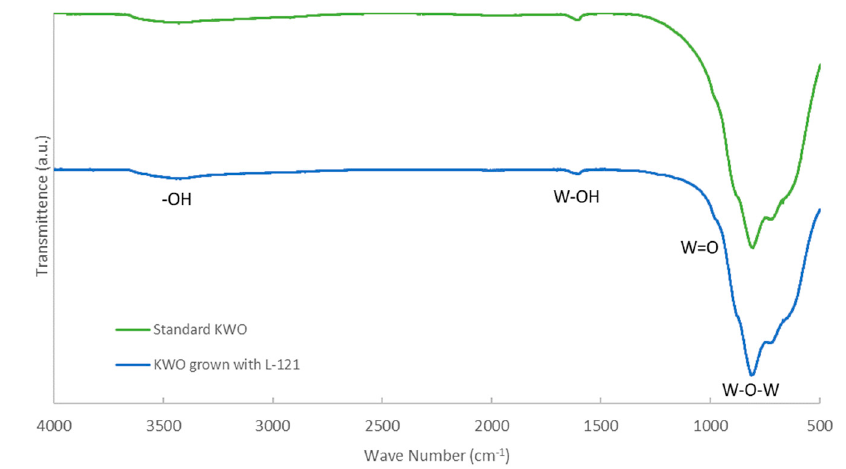
Figure 3. FT-IR of K x WO grown with and without L-121.